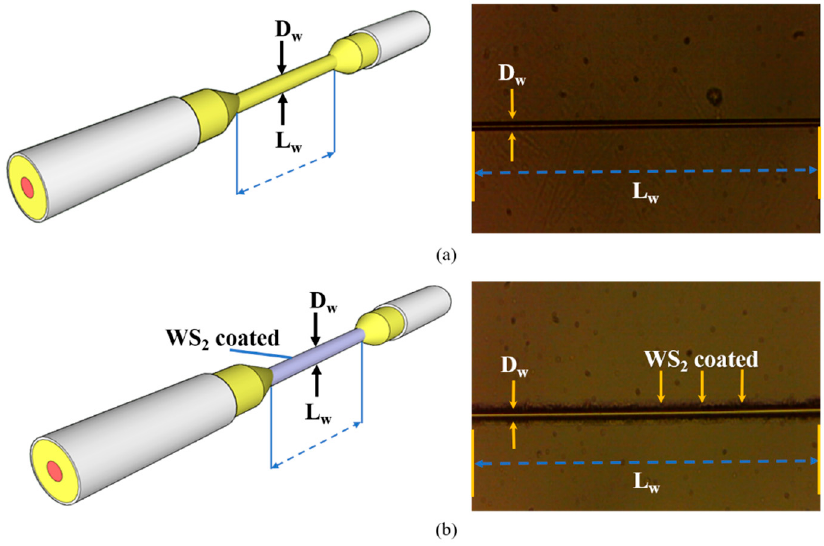
Figure 4. Microscopic images of MF structure ( a ) before coated and ( b ) after coated with WS 2 .